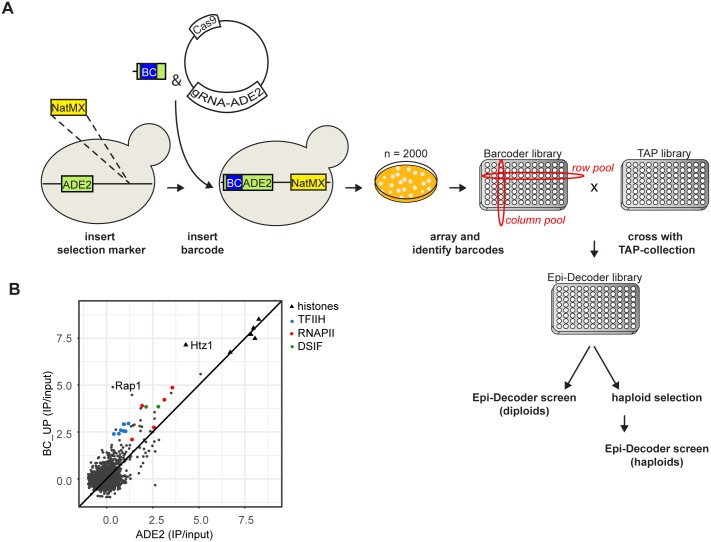
Application of Epi-Decoder to a native genomic locus.(A) Procedure to generate a custom Epi-Decoder collection. A selection marker (NatMX) was inserted in proximity to the locus of interest, downstream of the to-be-barcoded ADE2 gene. Subsequently, a Cas9- and gRNA-expressing vector was introduced in this strain together with a repair template that is composed of a 15 bp random barcode-sequence (BC) flanked by 40 bp arms with homology to the gRNA target site, here at the 5’ end of the ADE2 coding sequence (details see S5A Fig). Transformants, the vast majority of which represent barcoded clones, were transferred to an arrayed format. Rows and columns were pooled for identifying barcodes and their location on the array by high-throughput sequencing. The barcoder library was mated and crossed with the TAP-tagged protein library (see Fig 1) to generate heterozygous diploids and then haploids, after which Epi-Decoder screens could be performed. For diploid screens, the insertion of a selectable marker genetically linked to the barcode can be omitted. (B) Epi-Decoder results of BC_5’-ADE2 (n = 2, average) in diploid cells were compared to BC_UP in haploid cells (Fig 2). Binding scores were visualized in a scatterplot with histones shown as triangles and classes of proteins coloured: TFIIH, RNAPII, DSIF. BC, barcode; BC_5’-ADE2, barcode in 5’ region of ADE2; BC_UP, upstream barcode at HO locus; Cas9, CRISPR-associated protein 9; gRNA, guide RNA; IP, immunoprecipitation; TAP, Tandem Affinity Purification.